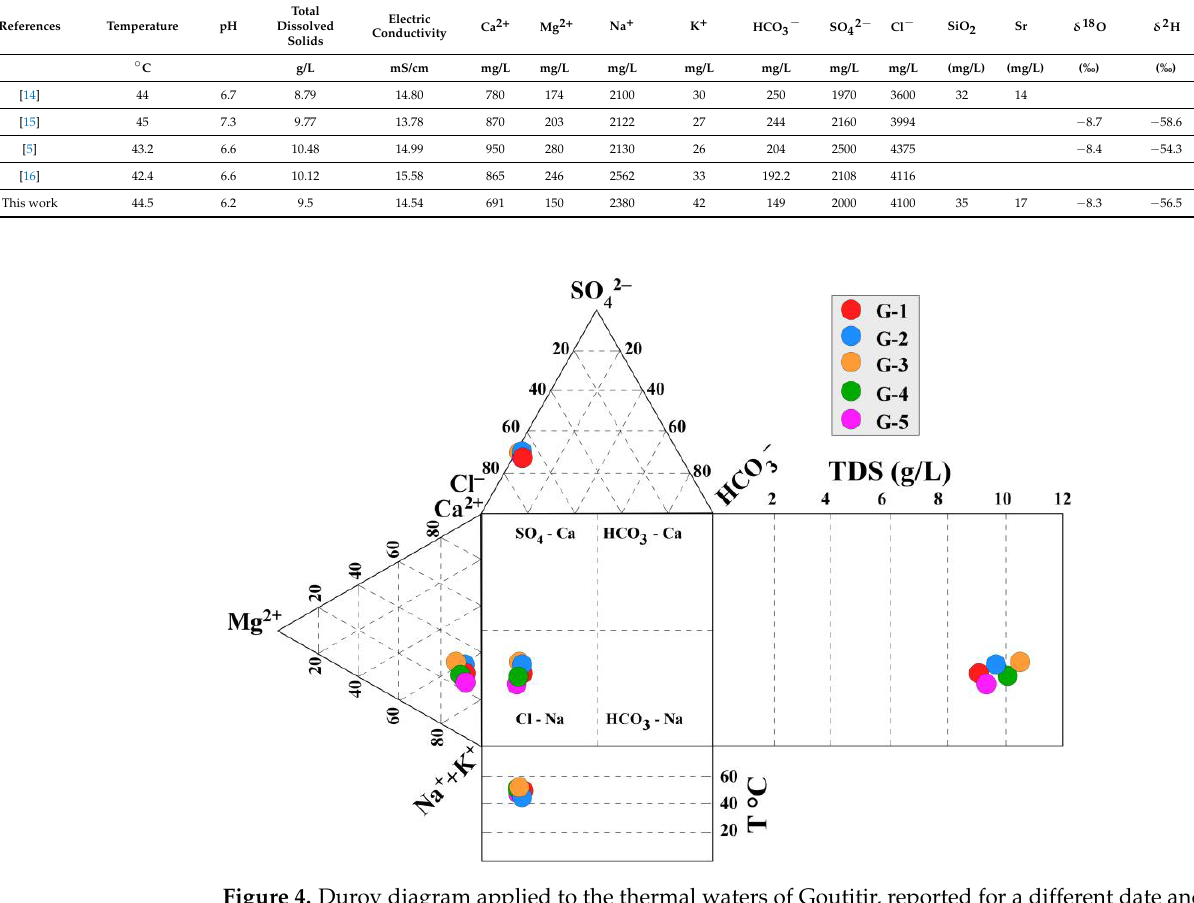
Figure 4. Durov diagram applied to the thermal waters of Goutitir, reported for a different date and from different authors (G1-[14]; G2-[15]; G3-[5]; G4-[16]; G5-this work, 2019).